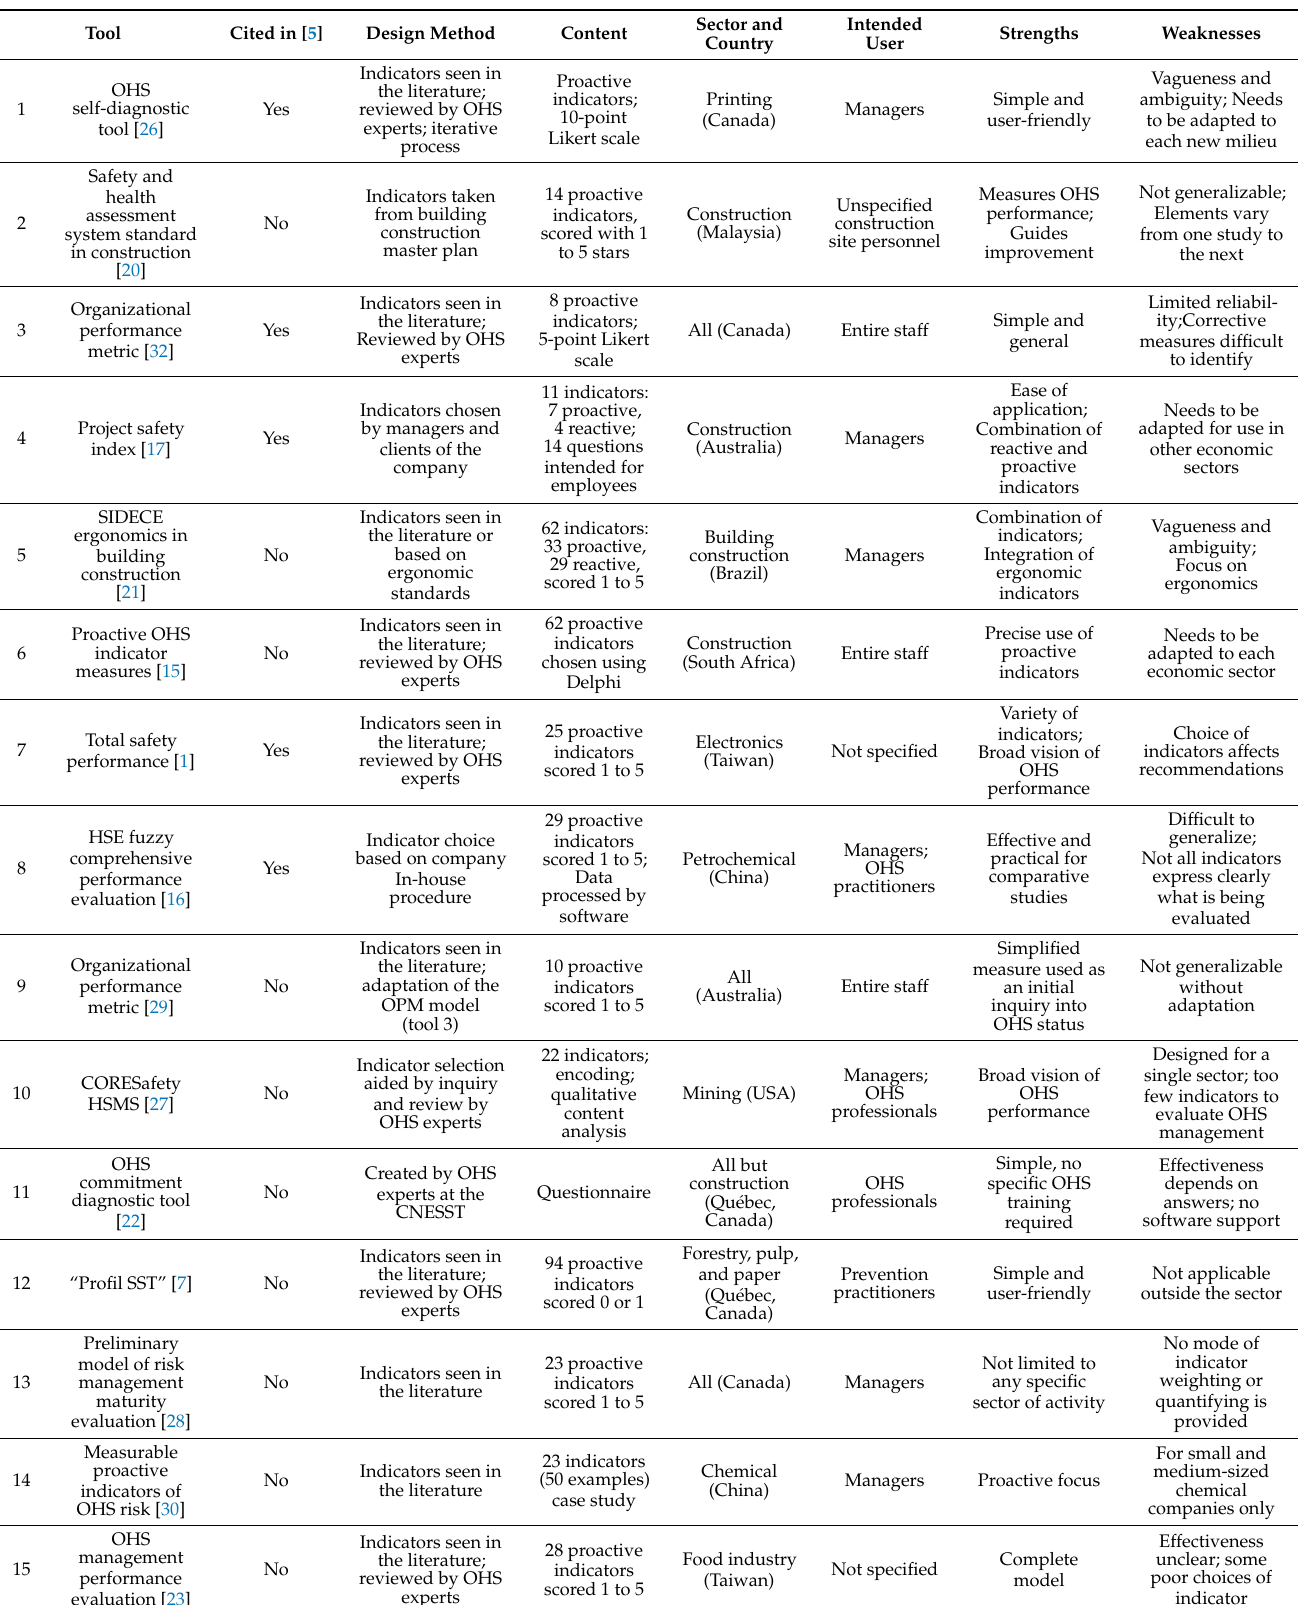
Table 17. Comparison of OHS evaluation tools proposed during the period